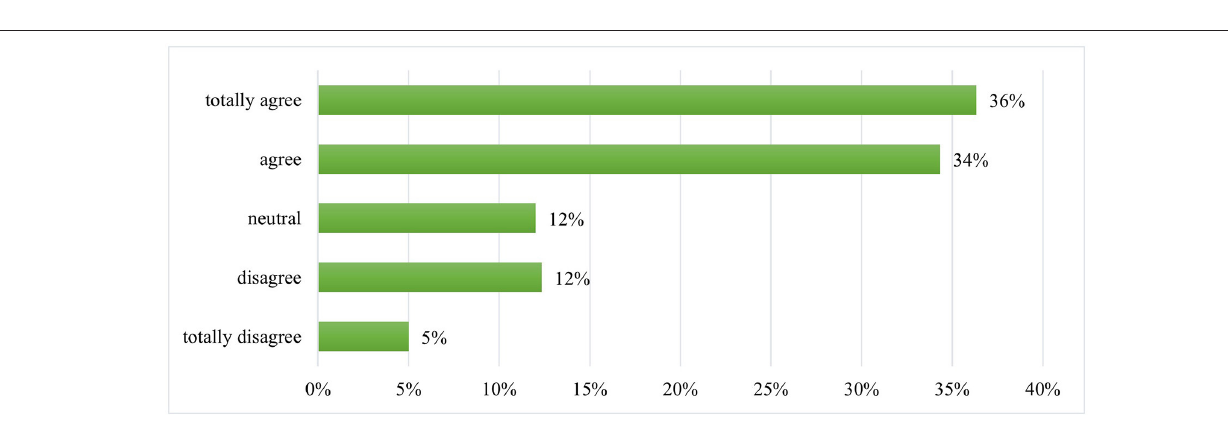
FIGURE 5 | Searching where and how food products are produced. Source: own processing and data collection.